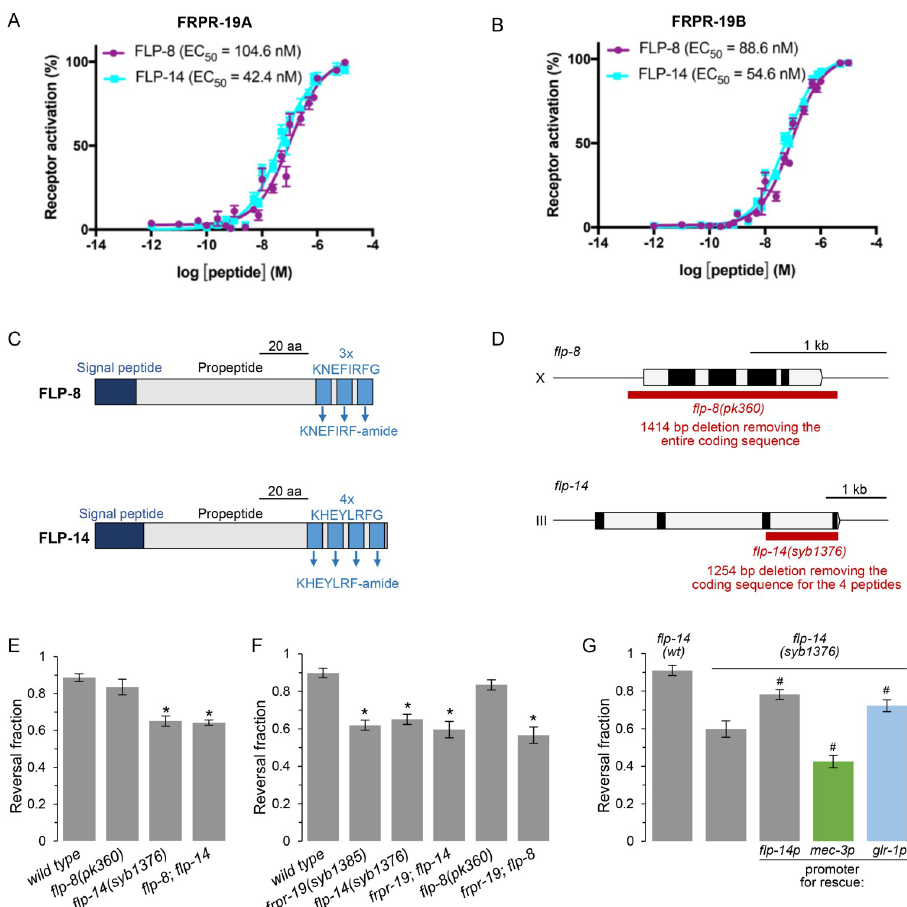
Fig 4. FLP-14 is an FRPR-19 ligand acting from interneurons to promote reversal. (A, B) Concentration-response curves of the mean calcium responses (% activation ± SEM) in CHO cells expressing either FRPR-19A (A) or FRPR- 19B (B) for different concentrations of synthetic peptides FLP-8 (solid purple circles) or FLP-14 (solid cyan squares). Solid lines indicate curve fits to the data ( n = 8). 95% confidence intervals (nM), FRPR-19A: FLP-8, 75.8–151.6; FLP- 14, 32.4–56.7 and FRPR-19B: FLP-8, 71.9–110.9; FLP-14, 46.9–63.8. (C) Schematic of the FLP-8 and FLP-14 propeptide structure. (D) Schematic of the flp-8 and flp-14 gene topology. Open boxes: introns and UTRs. Closed boxes: coding exons. Red boxes: deletions in the indicated mutant alleles. (E, F, G) Fraction of FLP optogenetic stimuli producing a reversal response scored as in Fig 1 for the indicated genotypes. Epistasis analyses between flp-8 and flp-14 null mutations (E), between flp-8 , flp-14 and frpr-19 null mutations (F), and cell-specific rescue in flp-14 null mutants suggesting that glr-1 -expressing interneurons represent a functionally relevant source of FLP-14 peptides (G). � , p < ,01 versus wild type and #, p < .01 versus flp-14 by Bonferroni contrasts. 14 exons containing the coding sequence for all four peptide repetitions (Fig 4D). Of the two mutations, only flp-14 mutation caused a decreased reversal response (Fig 4E). The defect in a flp-8;flp-14 double mutant was identical to that in flp-14 single mutant (Fig 4E). These results indicate that flp-14 , but not flp-8 , is essential to control FLP neuron-evoked aversive responses and are in line with a model in which FLP-14 could represent a functional FRPR-19 ligand in vivo , relevant to this phenotype. To further substantiate this model, we assessed potential genetic interactions between frpr-19 and each of the two neuropeptide genes. We could not observe a further reversal response decrease in double frpr-19;flp-14 mutants, whose response was indistinguishable from that in the single mutants (Fig 4F). These results indicate that frpr- 19 and flp-14 are part of the same genetic pathway. In contrast, the frpr-19 ; flp-8 double